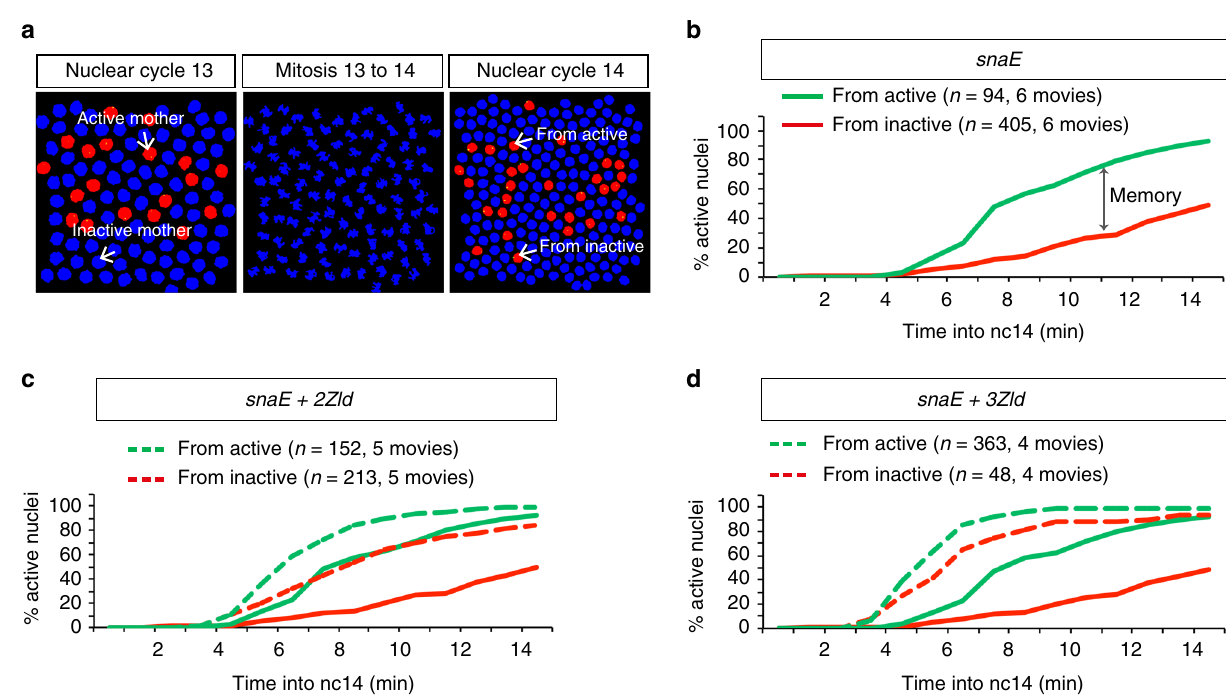
Fig. 2 Zelda accelerates gene activation regardless of transcriptional history a Representative images from the Graphical User Interface implemented for automatic tracking of nuclei across multiple divisions. Chromosomal splitting at the end of anaphase is automatically detected for each nucleus. b – d Quanti fi cation of transcriptional memory in various snaE < MS2 embryos. At each time point in nc14, the cumulative number of activated nuclei, expressed as a percentage of the total number of nuclei, is plotted after segregation into two populations: descendants of active mothers (green) and descendants of inactive mothers (red). The timing of activation of each nucleus has been normalized to its speci fi c timing of mitosis. Temporal dynamics from snaE are depicted using solid curves, while those from transgenes with extra Zld-binding sites are represented as dashed curves ( c , d